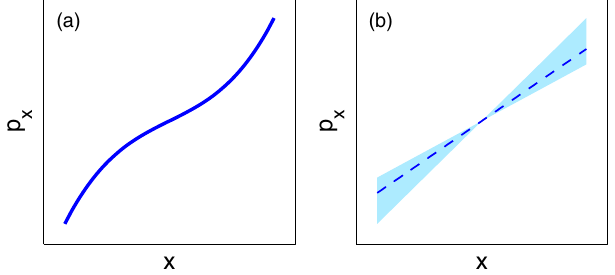
FIG. 15. Examples of projected phase space emittance growth from (a) geometric aberrations and (b) projected (slice) phe- nomena. The dashed line shows an individual slice either in time (for rf-induced emittance) or in energy (for chromatic